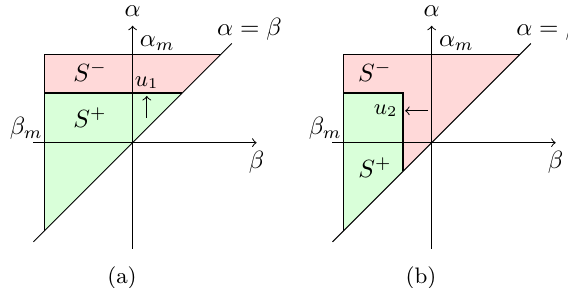
Figure 3: Illustration of the staircase memory curve of the Preisach